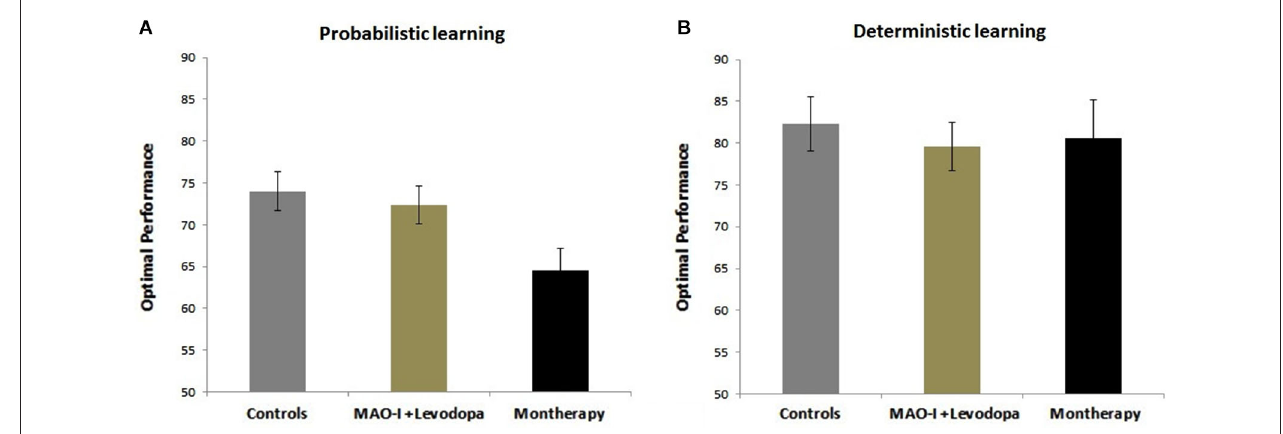
and levodopa show better performance than PD patients on monotherapy. (B) Deterministic learning task. There was no significant difference among PD and the healthy control groups in the deterministic learning task.